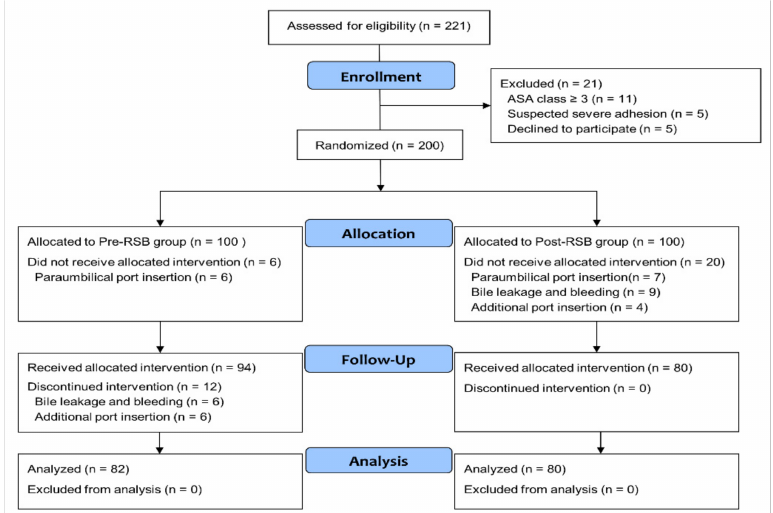
Figure 1. Flowchart of the study population. Abbreviations: ASA, American Society of Anesthesiologists; Pre-RSB, preoperative rectus sheath block; Post-RSB, postoperative rectus sheath